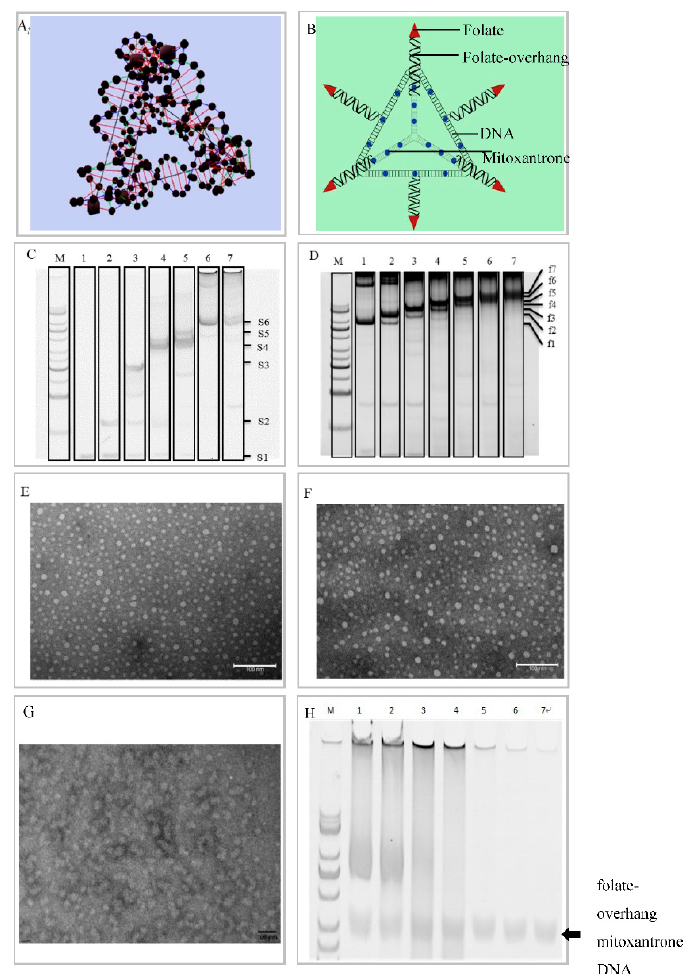
Figure 1. Precise synthesis of folate-overhung DNA tetrahedra. ( A ). The simulated image of DNA tetrahedra; ( B ). The schematic representation of folate-overhung DNA tetrahedra; ( C ). Polyacrylamide gel electrophoresis of the DNA tetrahedra formation; lane 1, strand 1 (S1); lane 2, strand 1-2